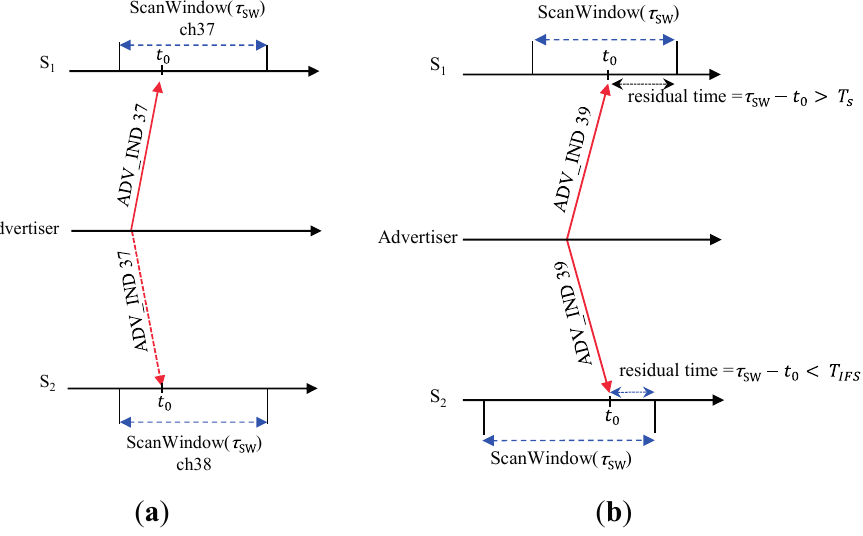
Figure 5. Cases for successful discovery in 1:2 networks ( a ) Case 2 ( E1 ∩ E2 ∩ E4 )); ( b ) Case 3 ( E1 ∩ E2 ∩ E4 ∩ E5